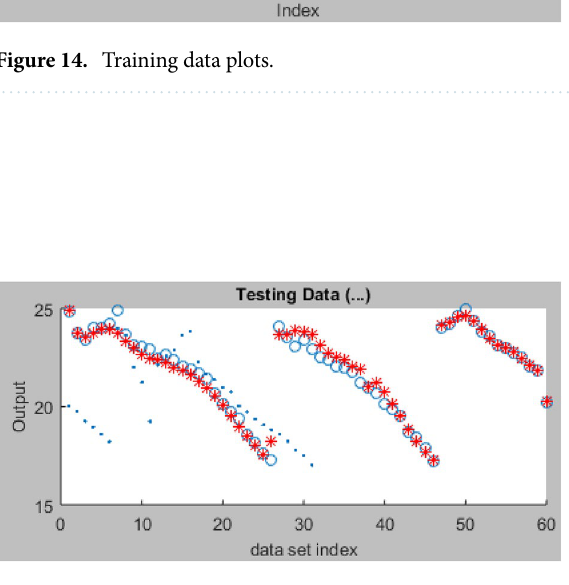
Figure 15. Plot of ANFIS training and testing data